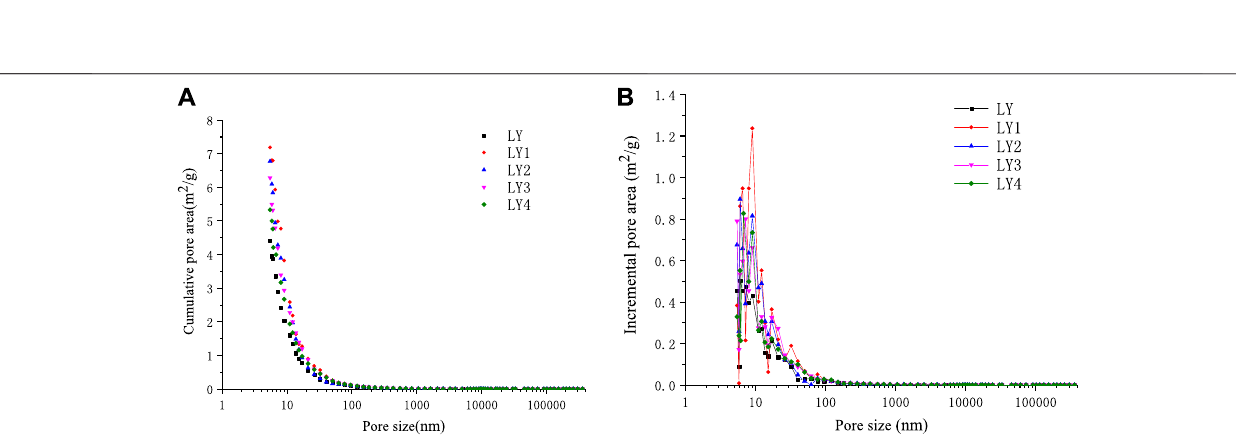
FIGURE 8 | Pore area vs pore size of Liulin mine soft coal after high-temperature and high-pressure adsorption test. (A) Cumulative pore area of soft coal (B) Incremental pore area of soft coal.